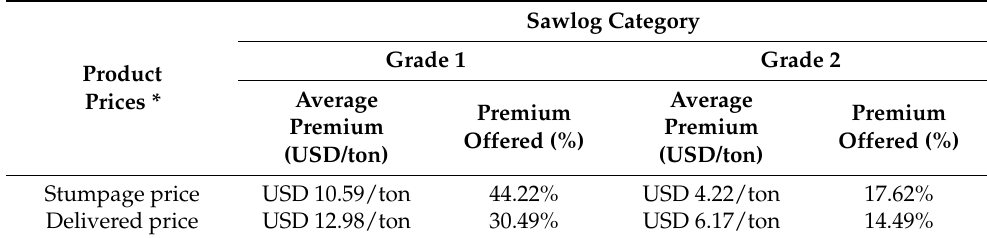
Table 5. Average and percentage price premiums offered for Grade 1 and Grade 2 pine sawlogs grown to an extended rotation age additional to the existing stumpage and delivered price across the southeastern United States based on a 2018 mail